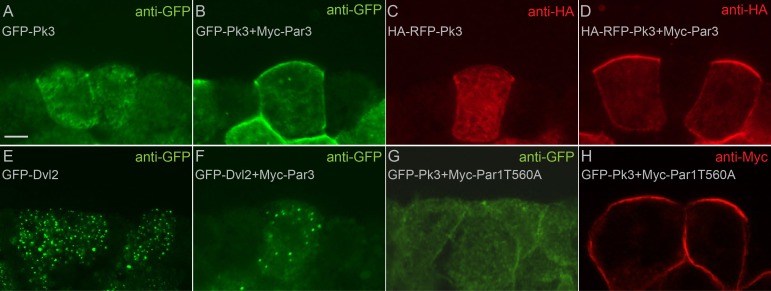
Par3 recruits Pk3 but not Dvl2 to the apical cell membrane.8–16 cell Xenopus embryos were injected animally with 100 pg of the RNAs encoding GFP-Pk3 (Pk3), HA-RFP-Pk3, GFP-Dvl2, Myc-Par3 and Myc-Par1T560A as indicated, cultured until stage 10.5, cryosectioned and immunostained for GFP (A, B, E–G), HA (C, D) or Myc (H). Myc-Par3 recruits GFP-Pk3 (A, B), but not GFP-Dvl2 (E, F), to the apical membrane. (C, D) Myc-Par3 promotes the apical localization of HA-RFP-Pk3. (G) Myc-Par1T560A does not promote GFP-Pk3 apical localization. (H) Myc-Par1T560A is cortically localized. Scale bar, 10 µm. The apical recruitment of Pk3 was observed in the majority (>90%, n > 100) of cells co-expressing Pk3 and Par3, but not in cells expressing Pk3 alone.